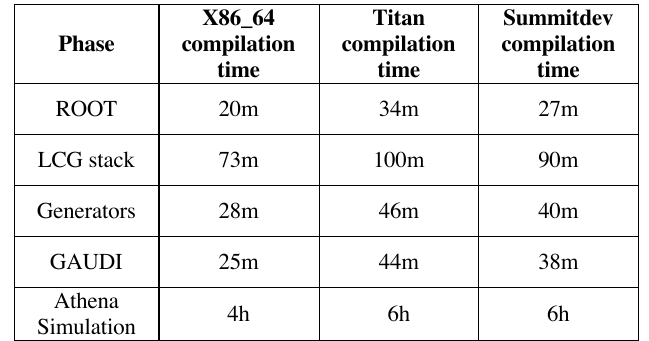
Table 1. Compilation (single stream make) times for different ACSC